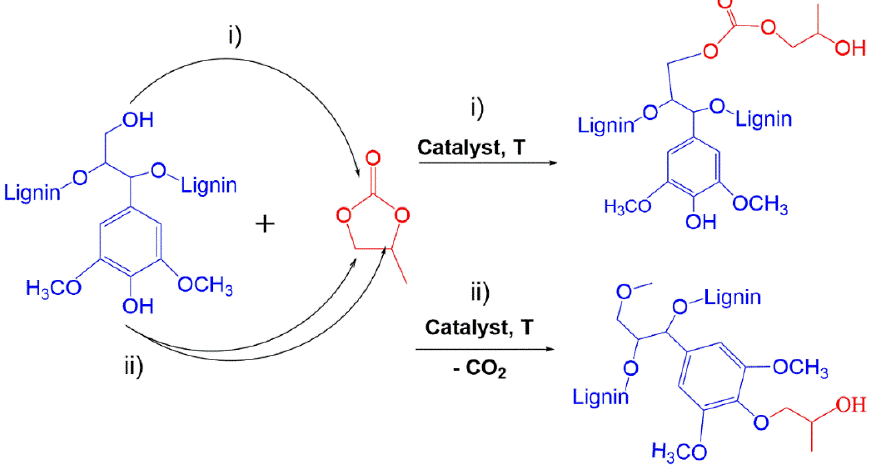
Figure 7. Scheme of oxypropylation of lignin with PC [18].